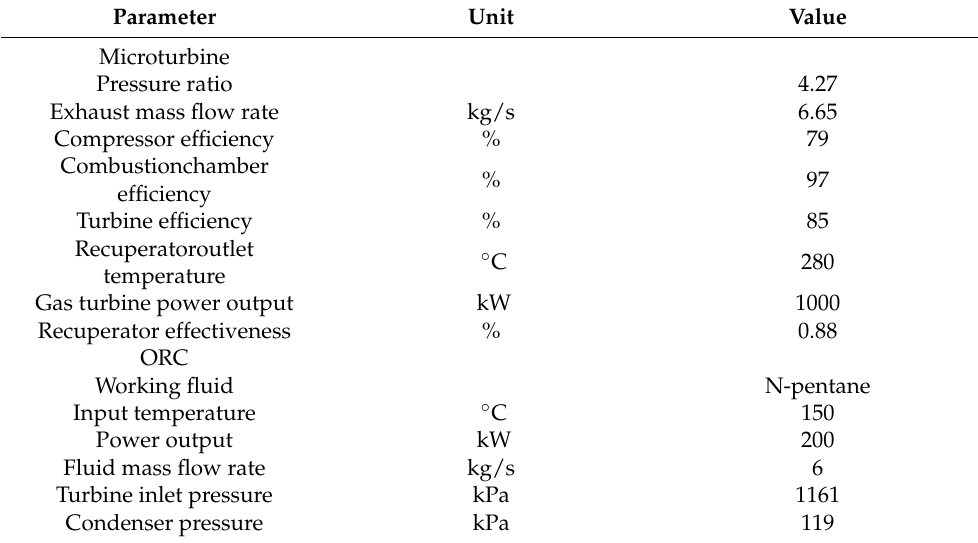
Table 2. Design specifications of the components of the CHP system [26,28,29].